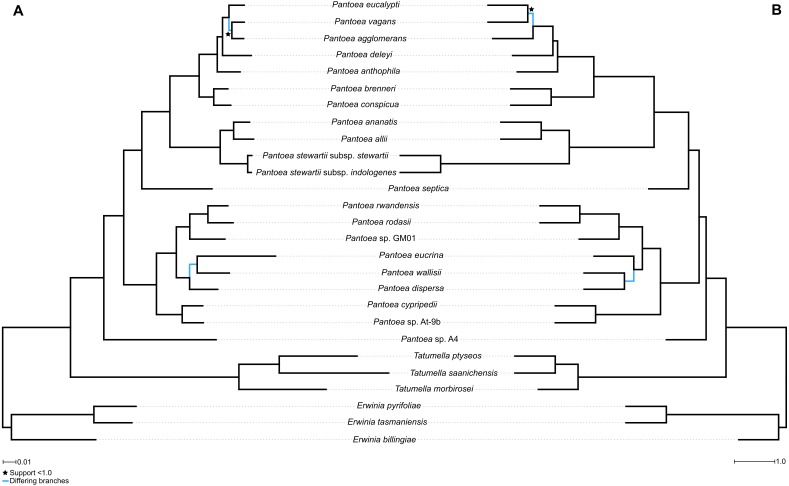
Comparison between the AML and MSCM phylogenies.Blue branches indicate differences in topology and branches with support of lower than 1.0 are indicated with a star. (A) The approximate maximum likelihood (AML) phylogeny constructed from the concatenated data matrix of the protein sequences of 1,357 genes, consisting of 337,780 amino acid columns. The phylogeny was constructed with FastTree v. 2.1 (Price, Dehal & Arkin, 2010) with the JTT (Jones, Taylor & Thornton, 1992) evolutionary model with CAT approximation. Simodaira-Hasegawa branch support values from 1,000 replicates were used. (B) A species phylogeny using the multispecies coalescent model as implemented in ASTRAL v.5.6.3 (Mirarab et al., 2014) based on the individual phylogenies constructed from the protein sequences of 1,357 genes. The scale bar indicates one coalescent unit (Mirarab et al., 2014). Terminal branches are indicated as one coalescent unit, as branch lengths for taxa corresponding to species can only be calculated where multiple individuals per species are analysed. Shorter branches correspond to higher levels of incongruence and are generally associated with high levels of incomplete lineage sorting (ILS). Support values are determined based on Bayesian posterior probability values computed from the single gene tree quartet frequencies (Sayyari & Mirarab, 2016).